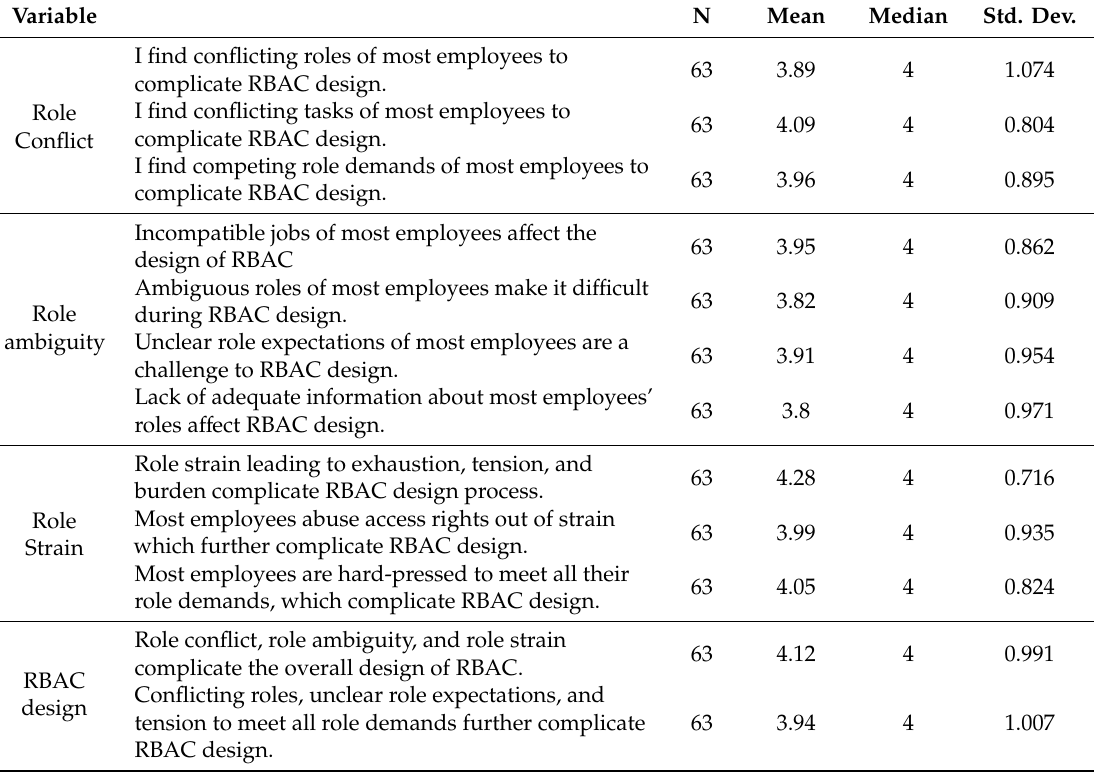
Table 4. Statistics of questionnaire items.